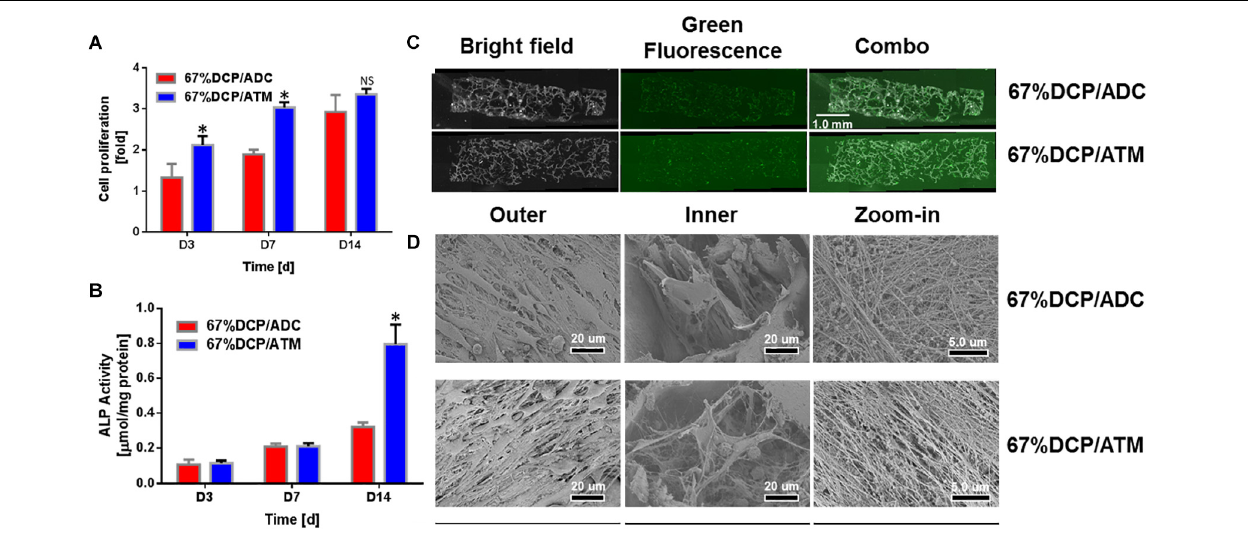
FIGURE 4 | MC3T3-E1 cell in vitro evaluation of composite scaffolds: (A) The cell number increase was significantly higher on 67%DCP/ATM than on 67%DCP/ADC ( p < 0.05) in the first week, and the cell number on both types of scaffolds showed no difference at day 14. * indicates significant differences. (B) ALP activity normalized to total protein content of MC3T3-E1 cultured on 67%DCP/ADC and 67%DCP/ATM for 3, 7, and 14 days. ALP activities were significantly higher on 67%DCP/ATM at day 14 ( p < 0.05) * indicates significant differences. (C) Viable cell distribution on both types of composite scaffold at day 14. (D) SEM microgragh of MC3T3-E1 cells on 67% DCP/ADC and DCP/ATM: left column: surface; middle column: inside pores; right column: ECM deposition.